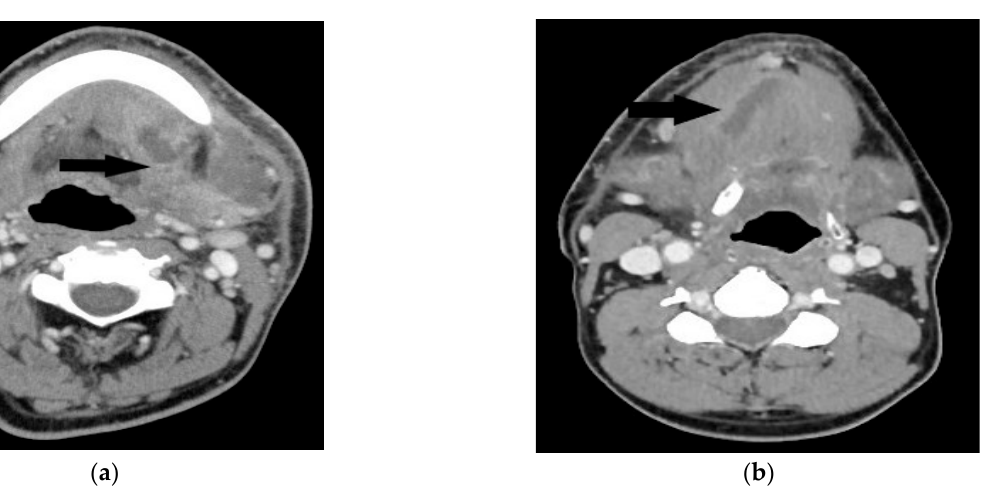
Figure 1. ( a ) Axial contrast-enhanced CT image reveals abscess (black arrow) in the left submandib- ular space. ( b ) Axial contrast-enhanced CT image shows a hypodense lesion (black arrow) in the submental space.